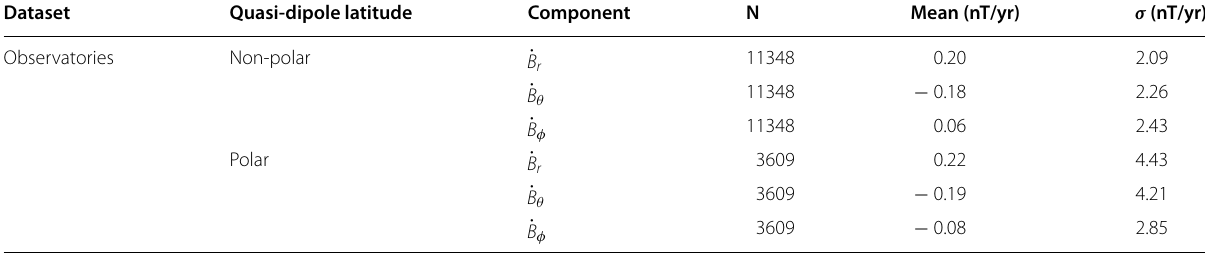
Table 6 Number N , Huber-weighted mean, and standard deviation σ computed from the residuals of the monthly ground observatory SV data for each component and split into polar (poleward ± 55 ◦ ) and non-polar (equatorward ± 55 ◦ ) QD